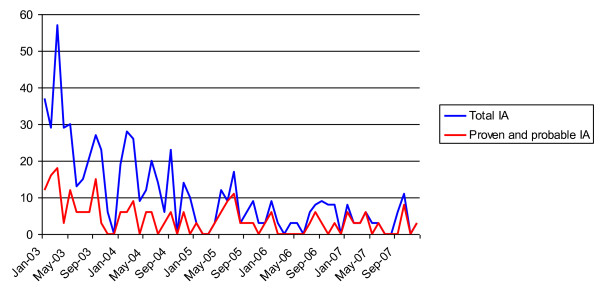
Monthly incidence of invasive Aspergillosis (IA).